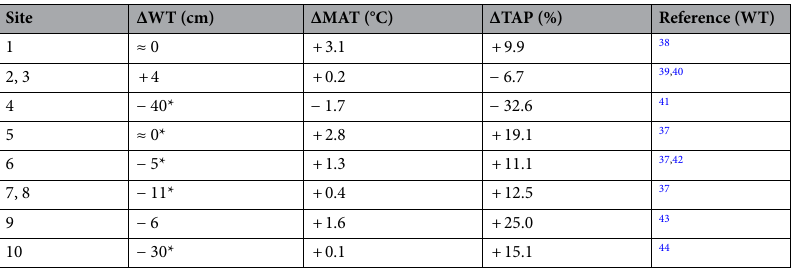
Table 2. Historical changes in water table depth (ΔWT), mean annual air temperature (ΔMAT) and total annual precipitation (ΔTAP) during the twentieth century at the sites shown in Fig. 1. Changes in TAP are specified in percent change. (−) indicates a decrease and (+) indicates an increase. (*) indicates WT data for another mire in the same region as the relevant site (Table